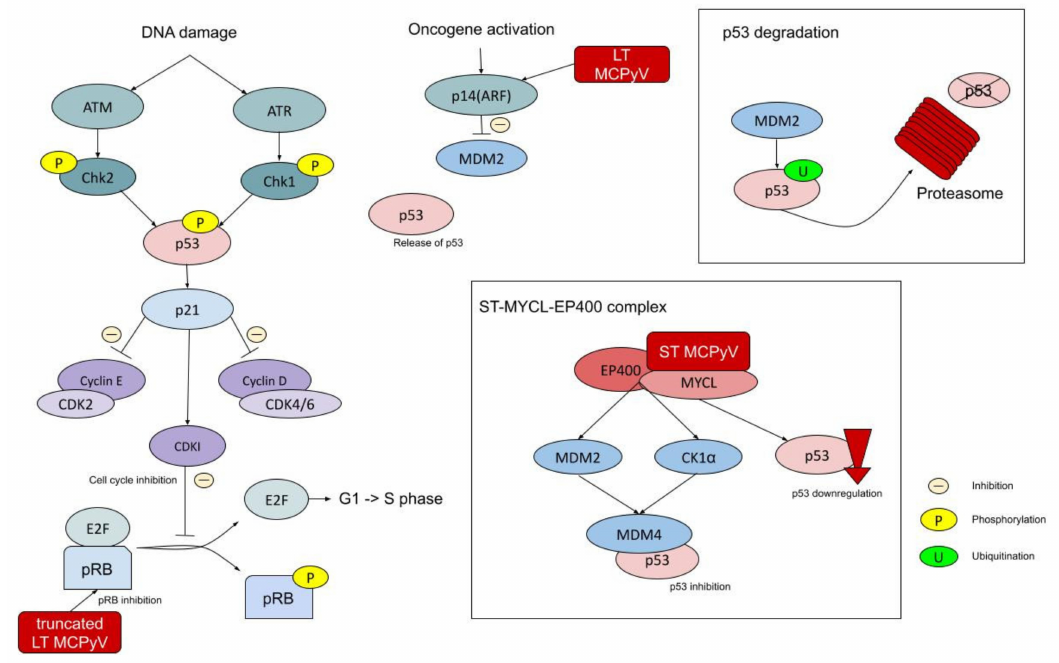
Figure 6. Alterations of pRB and p53 functioning in MCC. Truncated LT MCPyV inhibits pRB, causing E2F release and G1 to S phase transition. ST MCPyV binds to EP400 and MYCL, thus resulting in p53 downregulation as well as MDM4 overexpression by targeting MDM2 and CK1 α . In contrast, LT MCPyV induces accumulation of p14(ARF), which inhibits MDM2, thereby releasing p53. (ATM—ATM serine/threonine kinase, ATR—ATR serine/threonine kinase, Chk1/Chk2—checkpoint kinase 1/2, CDK2—cyclin-dependent kinase 2, CDK4/6—cyclin-dependent kinase 4/6, CKDI— cyclin-dependent kinase inhibitor, MYCL—MYCL proto-oncogene, bHLH transcription factor, EP400—E1A binding protein p400, MDM2—MDM2 proto-oncogene, MDM4—MDM4 regulator of p53, CK1 α —casein kinase 1 α , LT—large T antigen, ST—small T